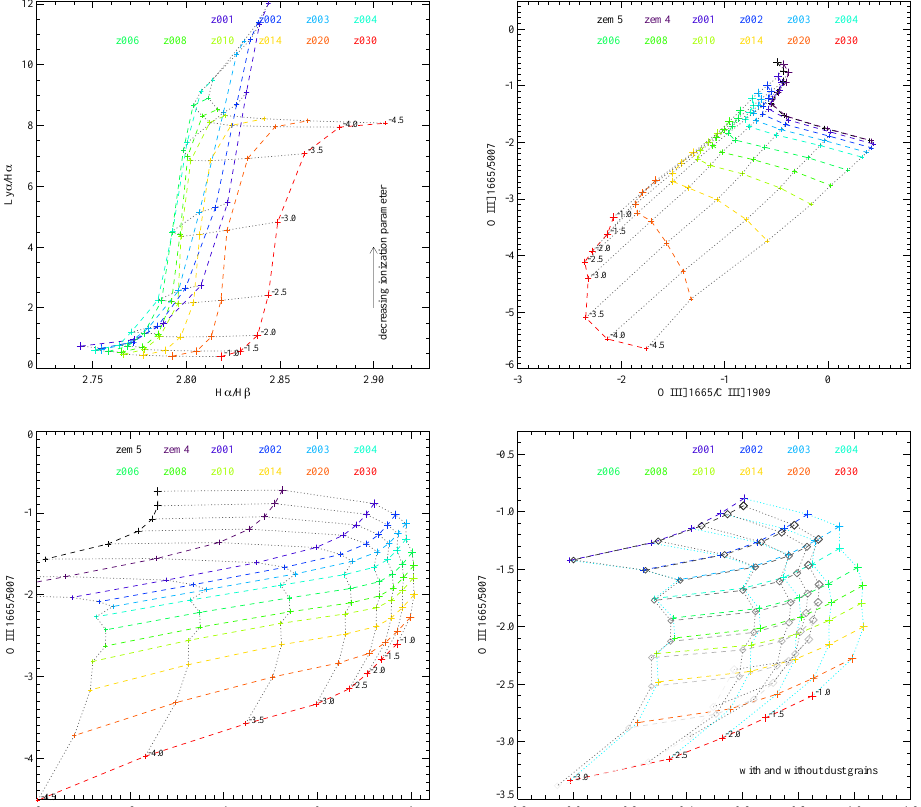
Figure 3. The power of ultraviolet line diagnostics to diagnose the physical conditions in ionised gas. In each case the same ionising spectrum (a continuously star forming stellar population at 100million years old) is processed through a nebular gas cloud with the same gas density (log( n e /cm − 3 ) = 2.3) and a range of ionisation parameters as labelled on the figures (decreasing this parameter is broadly equivalent to increasing the mean distance of the cloud from the source or decreasing the star formation rate). In the first three panels we show strong ultraviolet and optical emission line ratios which may be used as ionisation and metallicity diagnostics. On the lower right panel we demonstrate the importance of including dust grain surface physics (colour) or omitting it (greyscale) in an otherwise identical radiative transfer model (a subset of ionisation parameters and metallicities is shown for clarity). While the effect at low ionisation parameters is small, the higher ionisation parameters typical of the high star formation densities and binary populations seen in the distant Universe are very sensitive to the assumed physics. All models are from BPASS v2.2 [59], processed with CLOUDY. The metallicity of each line is labelled with “zem4”, “zem5”, “z001”, etc., indicating metallicity mass fractions of Z = 10 − 5 ,10 − 4 ,0.001